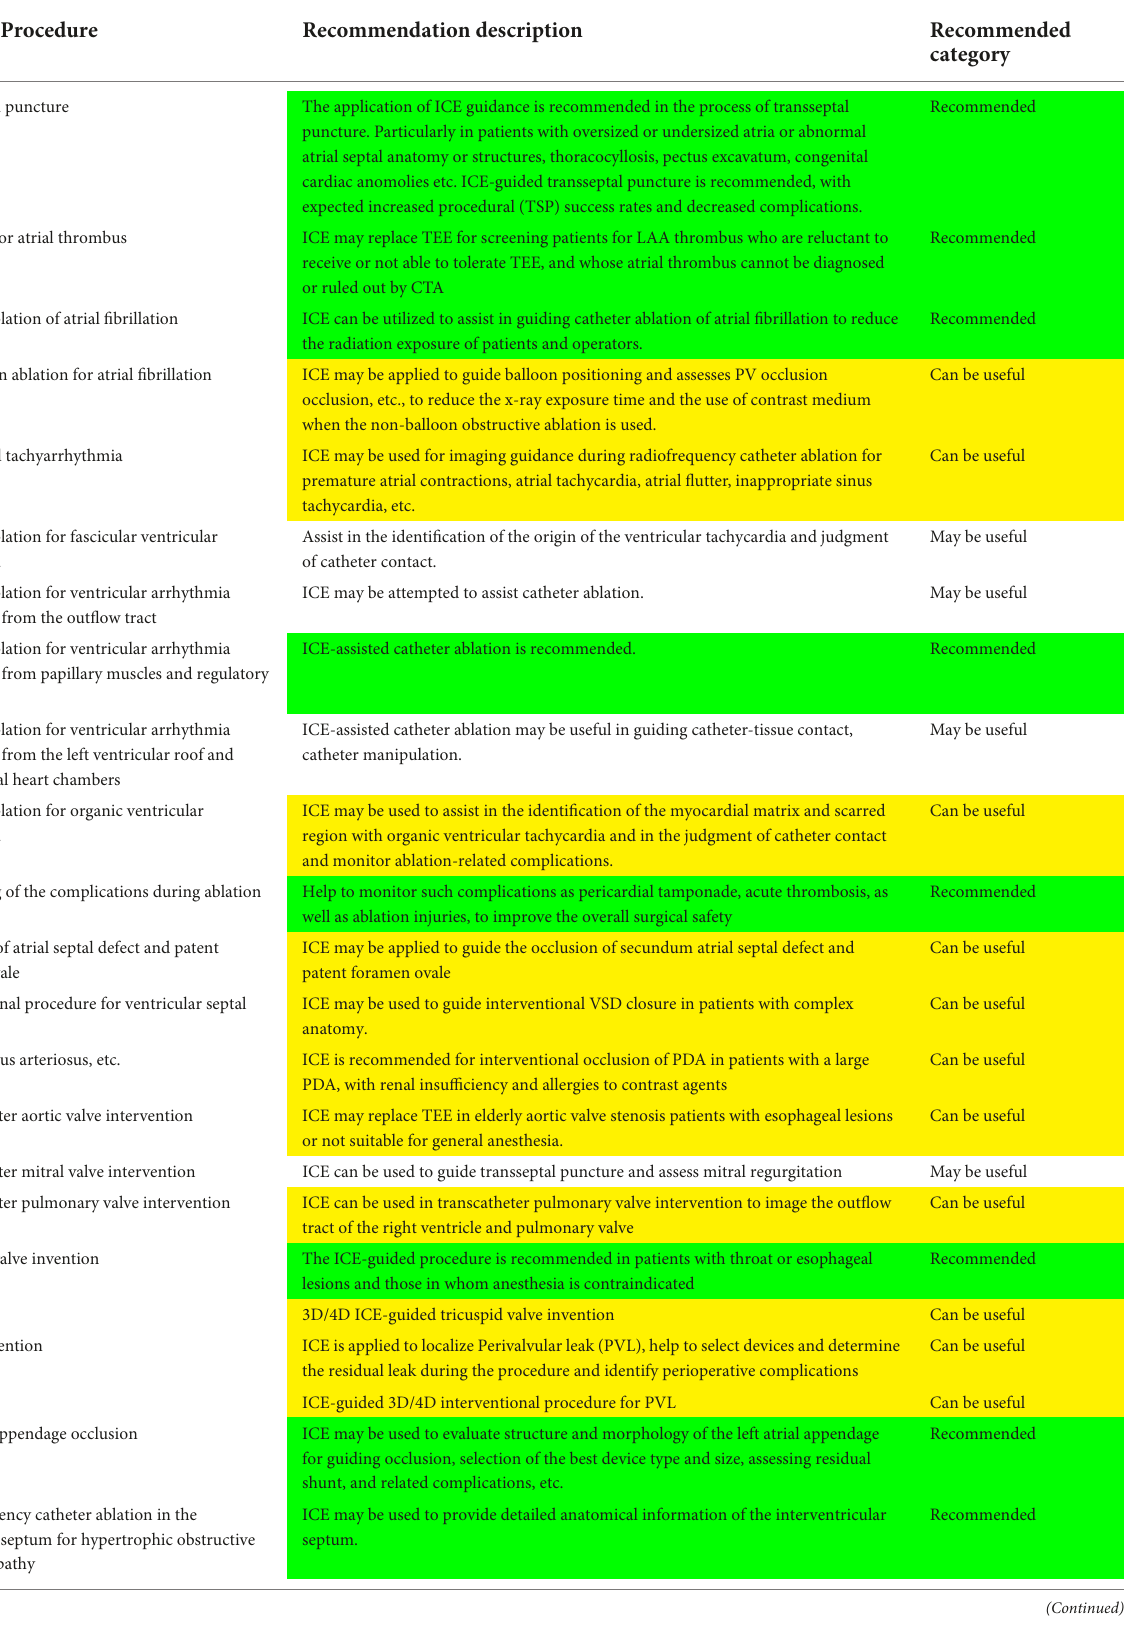
TABLE 2 Summary of recommended ICE